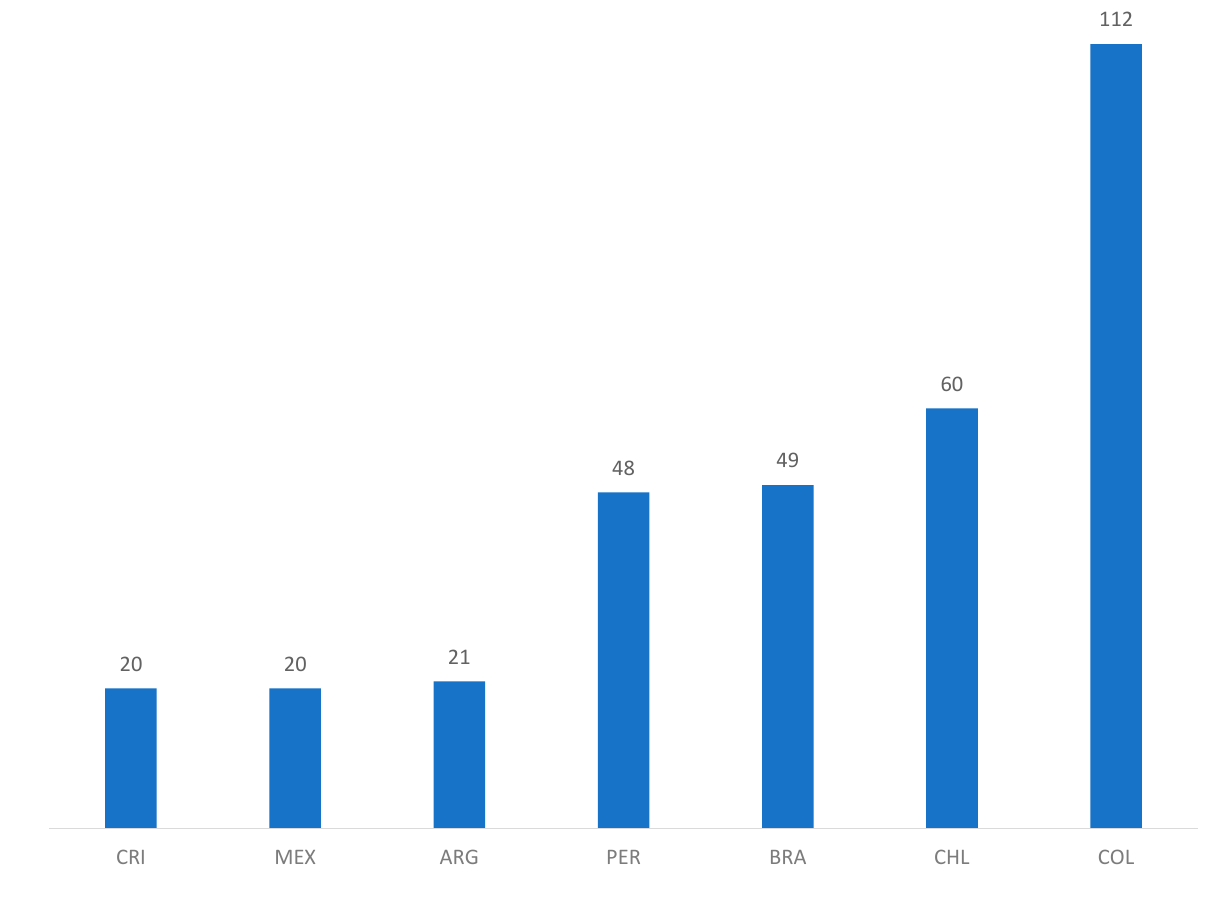
Figure 2. Hours needed to handle exports at port facilities. Source: World Bank, Doing Business 2019.